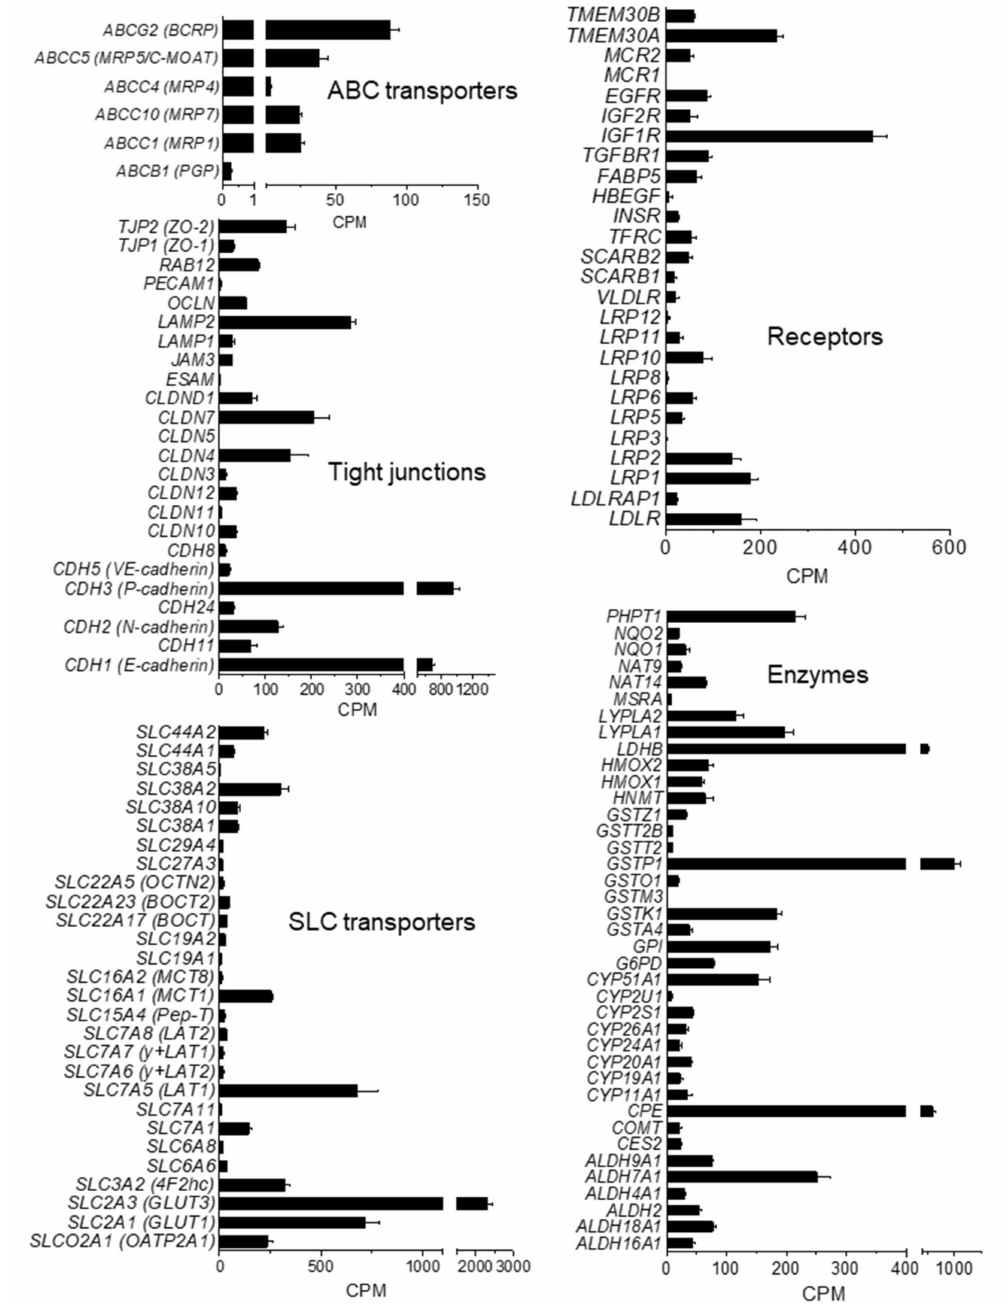
Figure 4. Transcription level of selected genes in iPSC-derived BMEC. mRNA levels at d1 co-culture, as counts per million (CPM), are expressed as mean ± SEM from two di ff erent rounds of di ff erentiation of Cl1 and RNA analysis, each with duplicate technical determinations of biological